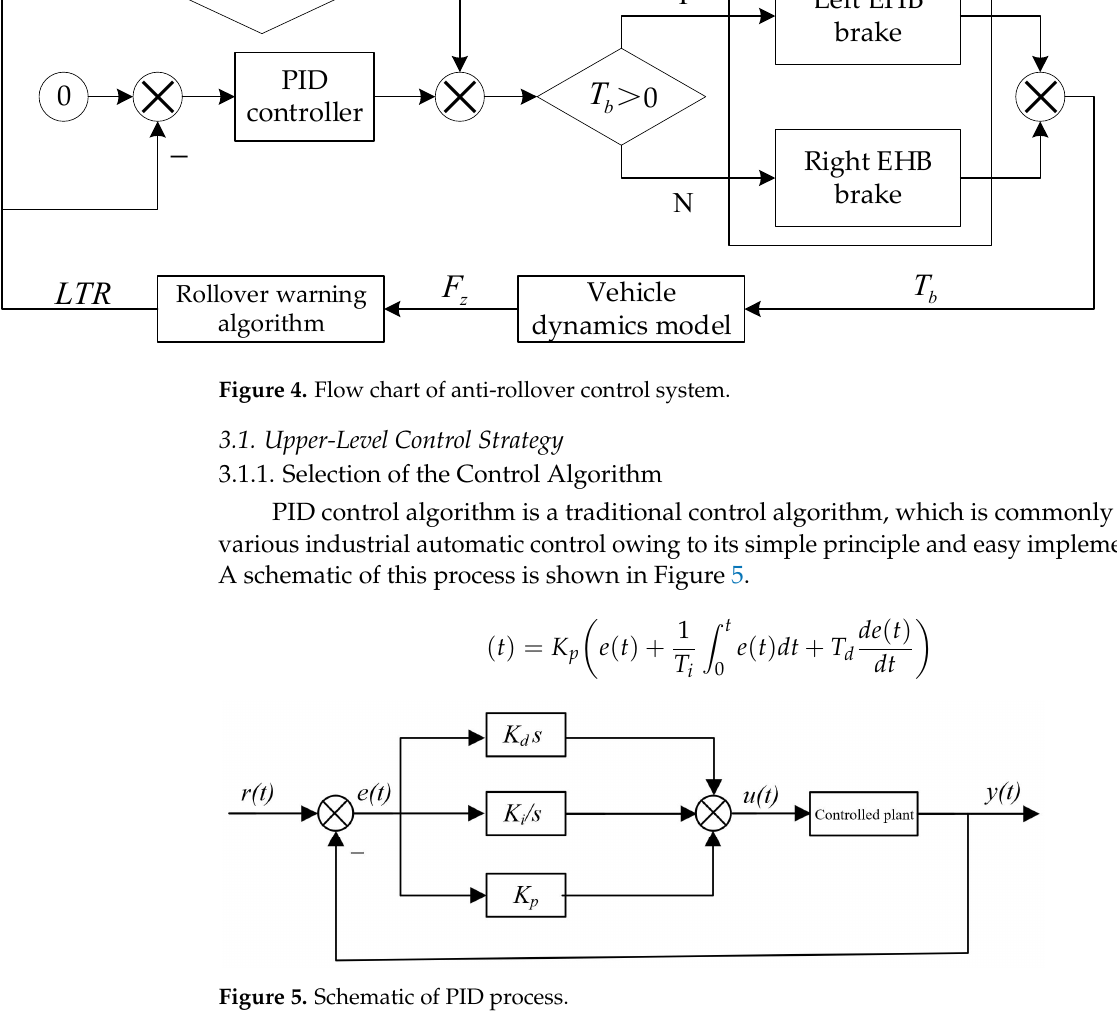
Figure 5. Schematic of PID process.